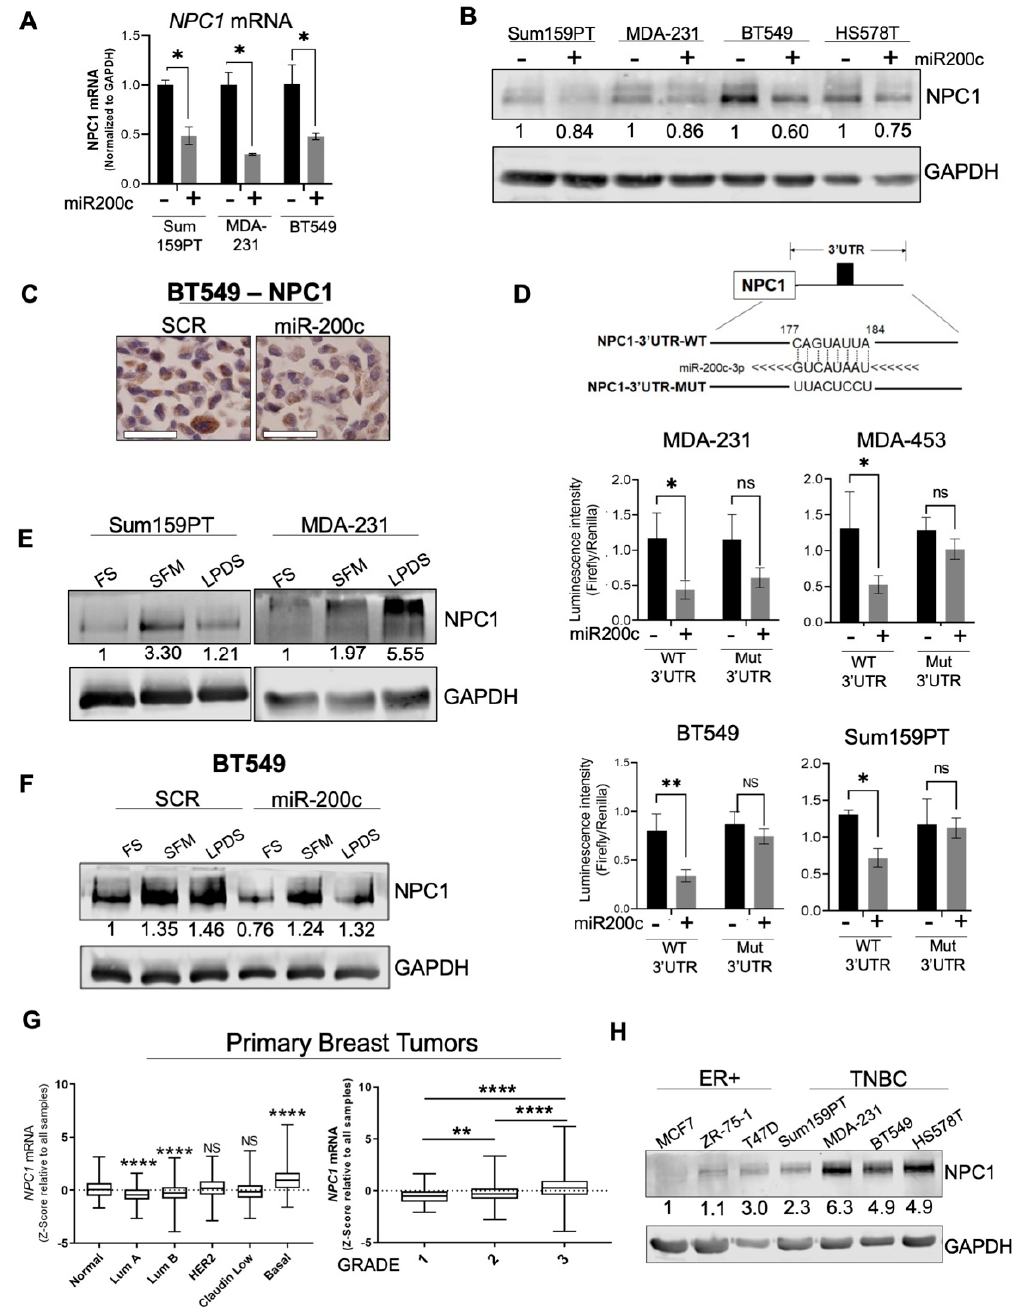
Figure 1. NPC1 is significantly elevated in aggressive breast cancers and is directly targeted by miR-200c. ( A ) Effect of miR-200c on NPC1 in three TNBC cell lines by qPCR after a 48-h transfection. Unpaired t -Test ( B ) Effect of miR-200c on NPC1 following a 72-h transfection. ( C ) Immunohistochemistry of NPC1 in BT549 (/+ miR-200c, scale bar = 50 µm. ( D ) Luciferase assay performed on wildtype (WT) or mutated (Mut) NPC1 3’UTR, with and without exogenous miR-200c. (Student’s t -Test) ( E ) Western blot of NPC1 in serum-free media (SFM) or lipoprotein depleted serum (LPDS) for 24 h, in two TNBC cell lines. ( F ) Effect of miR-200c on NPC1 induction by a 24-h SFM and LPDS treatment. miR-200c transfection = 96 h. ( G ) NPC1 in 2019 METABRIC breast cancer cohort by subtype (left, One-way ANOVA with Tukey Test, relative to “normal”) and grade (right, one-way ANOVA with Tukey Test). ( H ) Western blot of baseline NPC1, a panel of breast cancer cell lines. p -values denoted by asterisks where * ≤ 0.05; ** ≤ 0.01; **** ≤ 0.0001; or ns = not significant (>0.05).